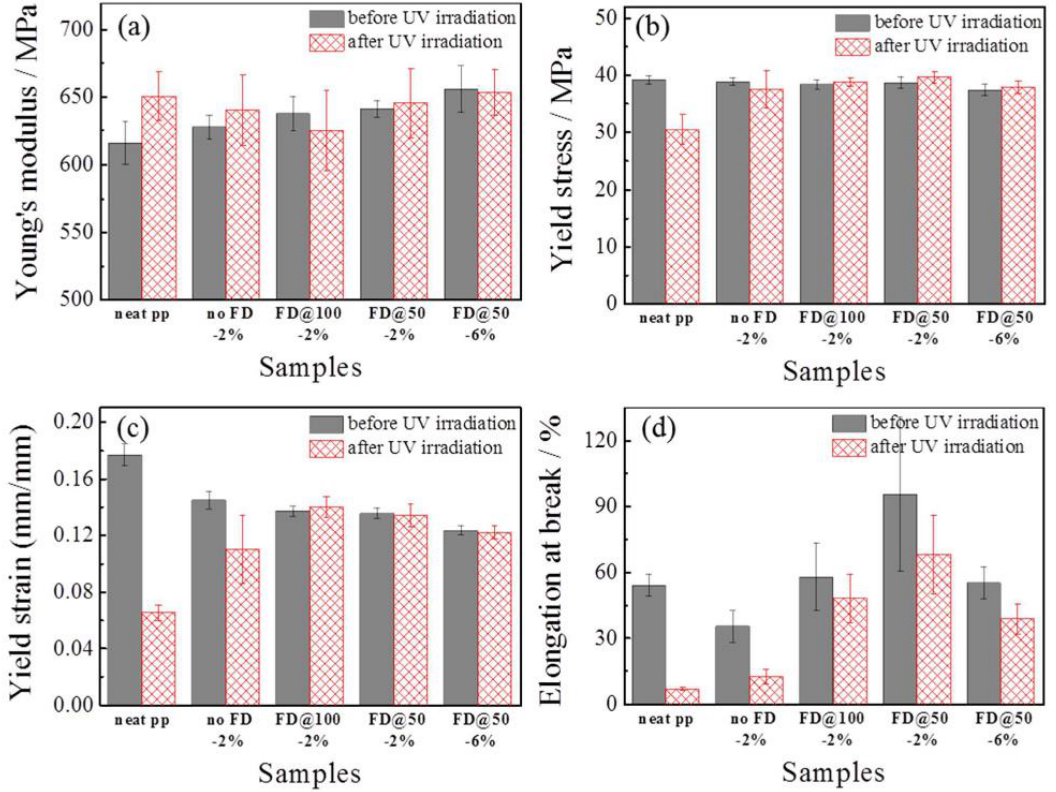
Figure 12. Tensile mechanical properties of the PP/lignin composites before and after UV irradia- tion. ( a ) Young’s modulus, ( b ) yield stress, ( c ) yield strain, and ( d ) elongation at break of neat PP, PP/lignin composites with 2 wt.% as-received lignin (no FD-2%), 2 wt.% freeze-dried lignin at a lignin concentration of 100 mg/mL (FD@100-2%), 2 wt.% freeze-dried lignin at a lignin concentration of 50 mg/mL (FD@50-2%), and 6% freeze-dried lignin at a lignin concentration of 50 mg/mL (FD@50-6%). Reproduced from [111], with the permission of the American Chemical Society.